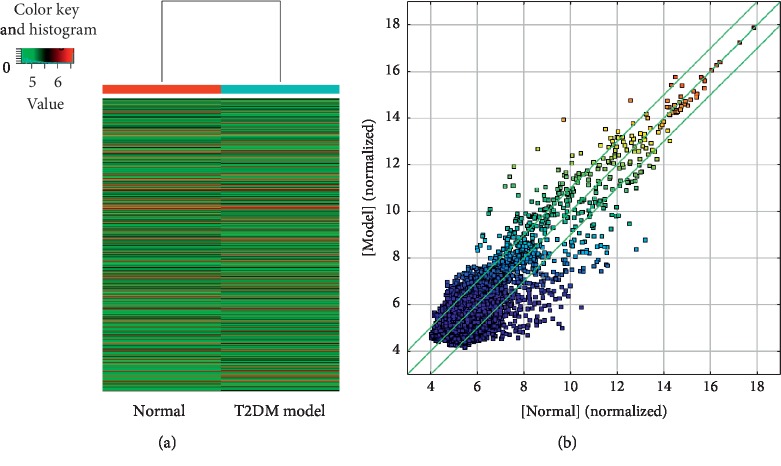
Identification of differentially expressed circRNAs between β-cells from normal and T2DM rat islets. (a) The heatmap depicts an intuitive graphical representation of gene expression in different samples after hierarchical clustering of all circRNAs. (b) Scatter plots of chip data assessing overall distribution of the two sets of data. The X and Y axis values in the scatter plot are the normalized signal values of the samples (log2 scaled). Portions beyond the lines indicate differentially expressed circRNA (fold change > 2.0 and P values ≤ 0.5).